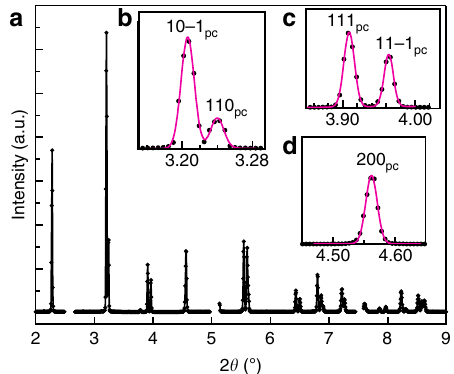
Fig. 1 X-ray diffraction results. a Integrated segment of diffraction images of BiFeO 3 driven at 6 kV mm − 1 and 1 Hz cyclic electric fi eld (see Methods). Insets indicate pro fi le fi tting using Gaussian peak functions on b 110 pc , c 111 pc , and d 200 pc , enabling the extraction of peak position, 2 θ , and intensities of these individual single and double peaks